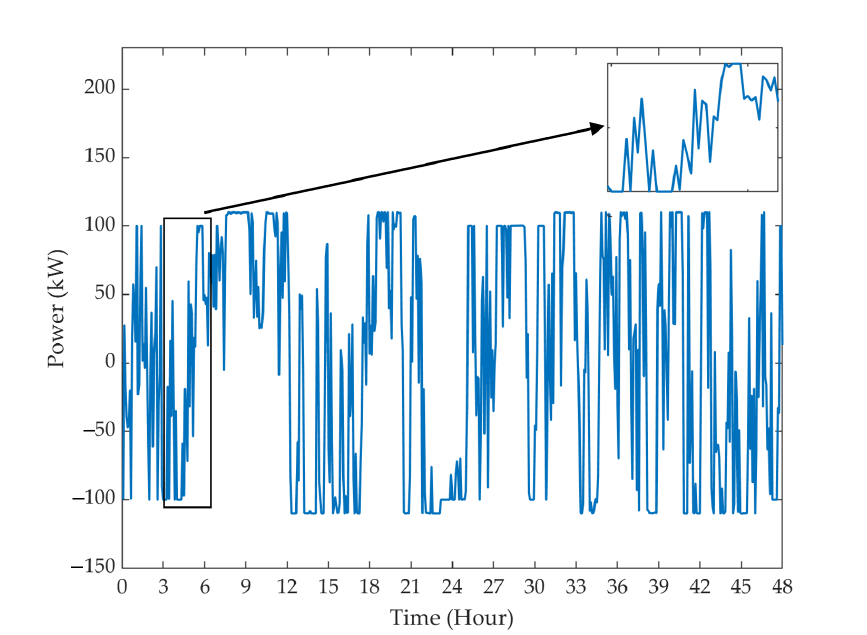
Figure 4. Frequency regulation reference signal